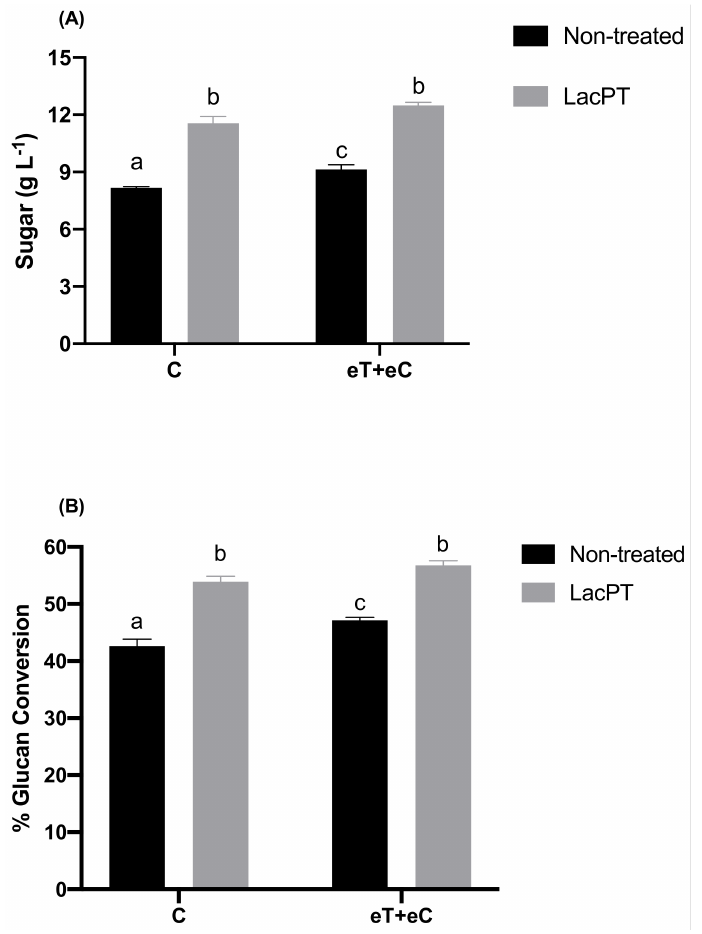
Figure 4. Sugar yield (g L − 1 ) ( A ) and Glucan conversion (%) ( B ) after enzymatic hydrolysis (5% solid load and 48 h) for non-treated and pretreated P. maximum at different climate conditions. Treatments: Control (C) and elevated temperature + elevated CO 2 (eT+eC). Mean values ± SD ( n = 3) marked with different letters above bars symbolize statistical differences among treatments ( p ≤ 0.05, Tukey’s